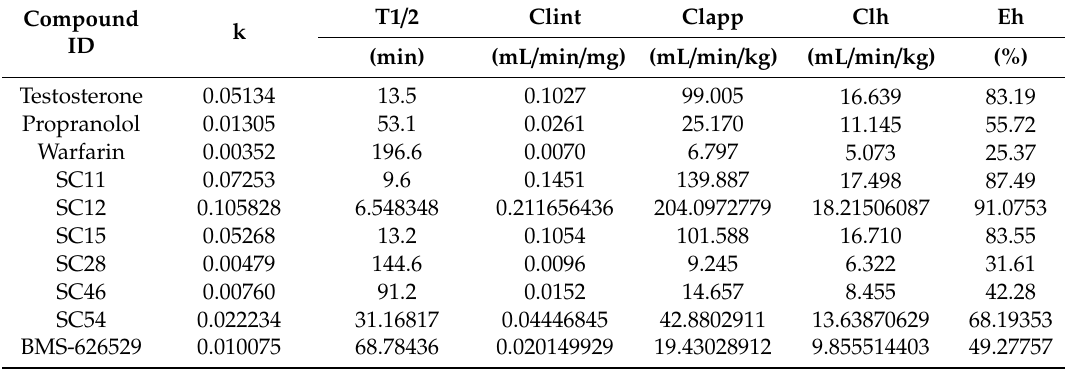
Table 2. Metabolic stabilities of control and test compounds in a human liver microsome assay. Predictive PK parameters were derived as outlined in Materials and